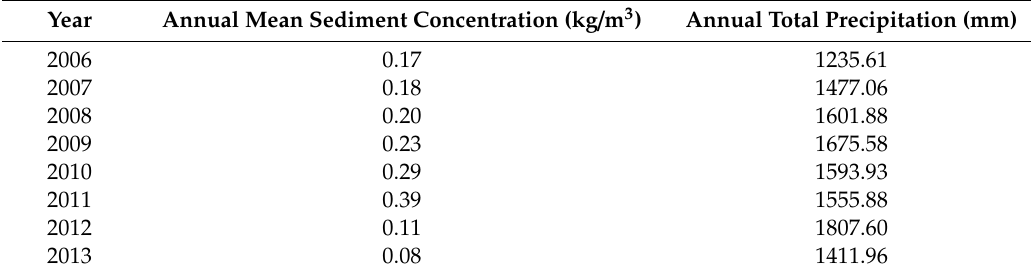
Table 6. The annual mean sediment concentrations and annual total precipitation from 2006 to 2013. Year Annual Mean Sediment Concentration (kg / m 3